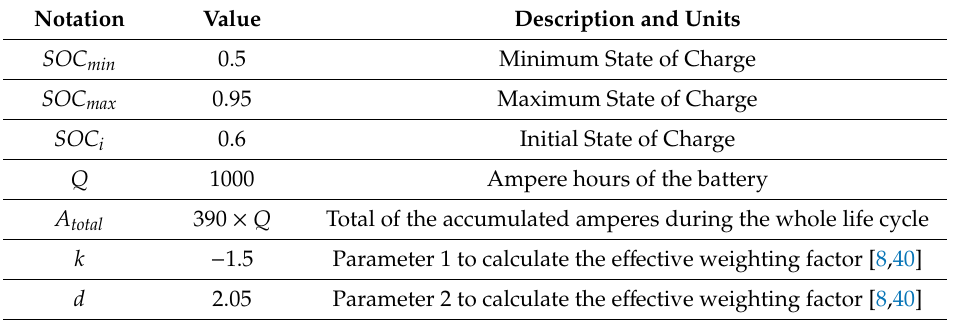
Table 3. Battery parameters (for F 3 ( x ) calculation).